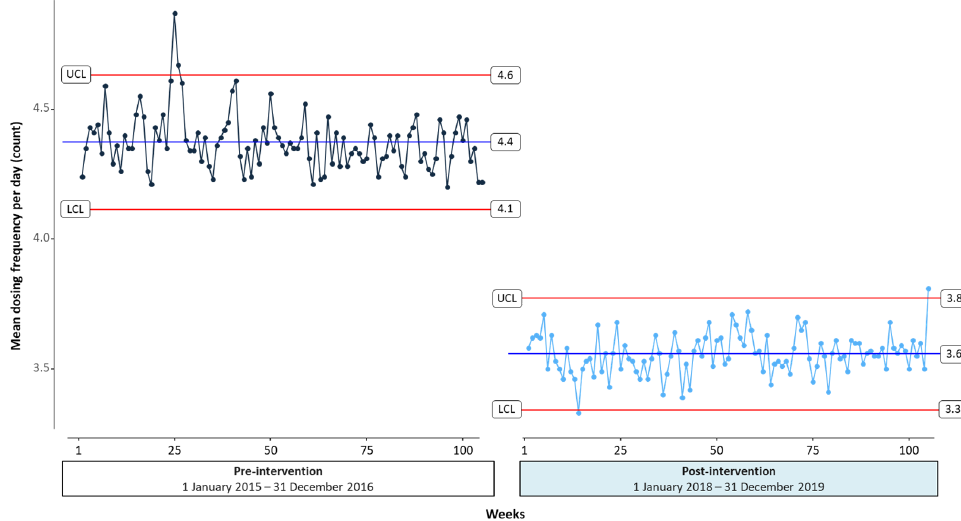
Figure 2. Control chart of mean dosing frequency over time. UCL; upper control limit; LCL; lower control limit.